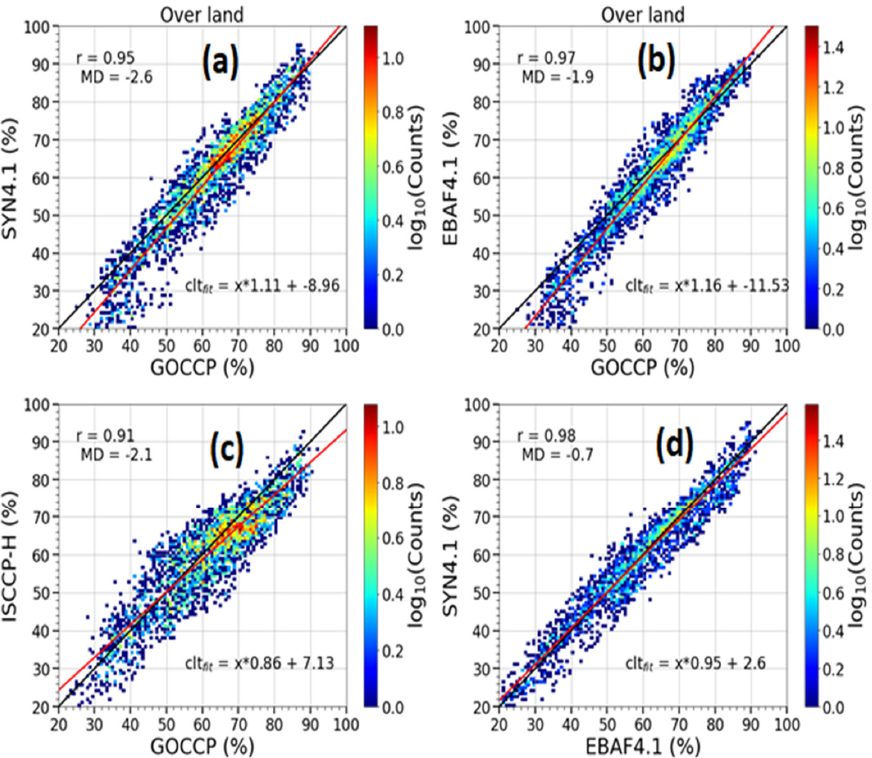
Figure 2. The same as Figure 1, but over the continental regions.